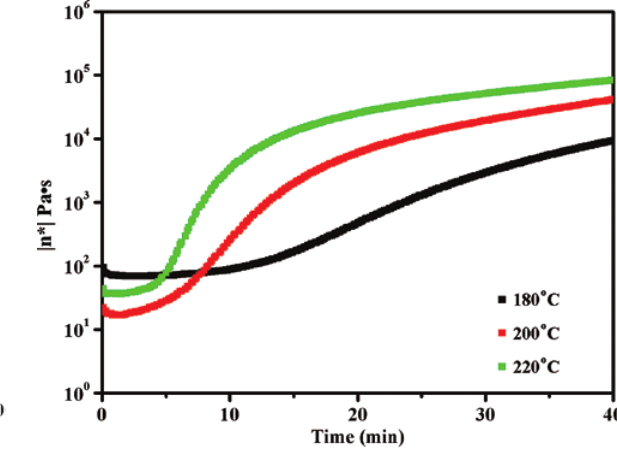
Figure 4: Temperature vs. viscosity curves of BAPh/PEN-OH pre- polymers with various PEN-OH contents.